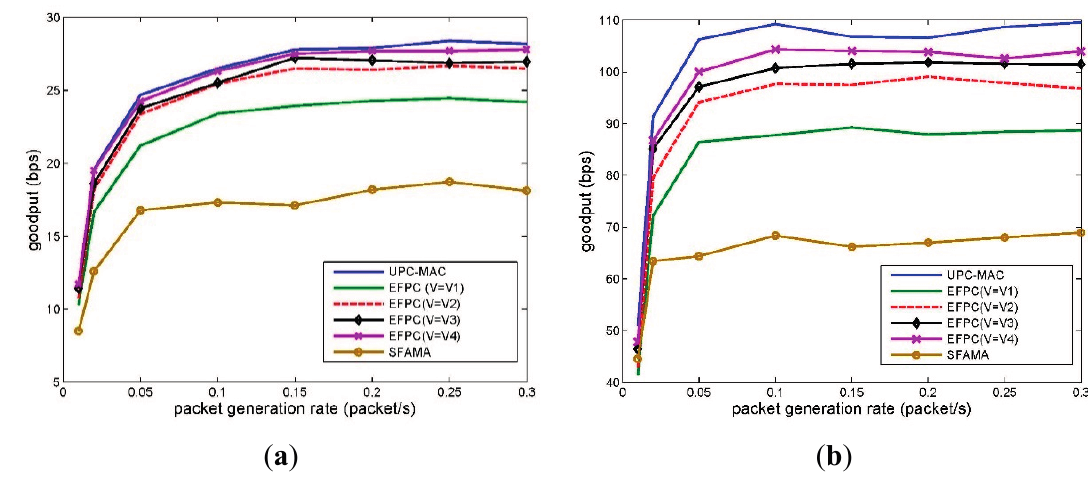
Figure 12. Network goodput. ( a ) Packet length 100 B; ( b ) Packet length 500